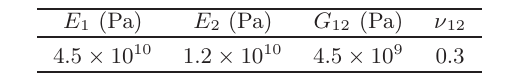
Table 2. Mechanical properties of laminated composite plate.